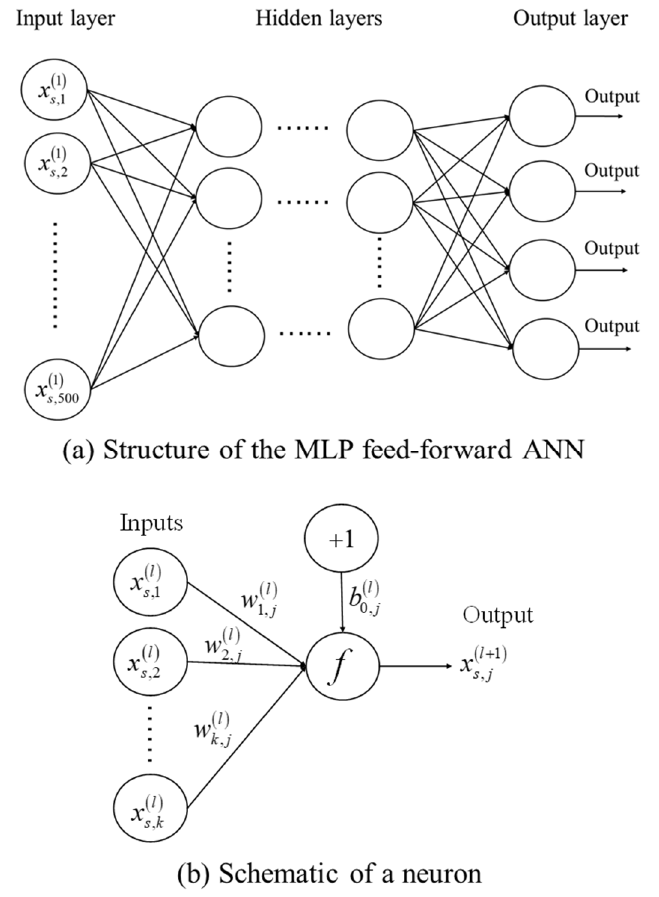
Figure 7. Structure of the MLP feed-forward ANN: ( a ) Structure of the MLP feed-forward ANN. ( b ) Schematic of a